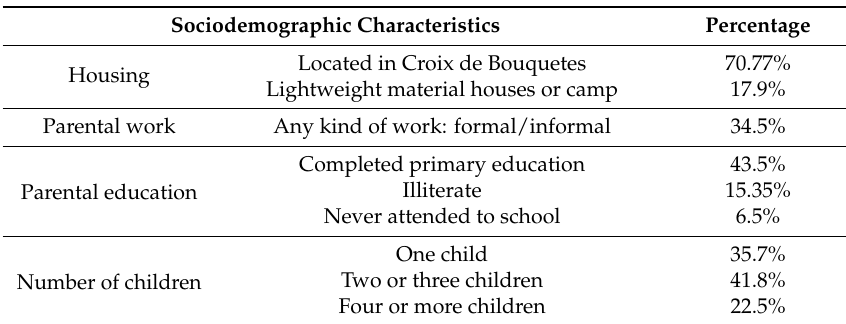
Table 1. General sociodemographic information in in 278 infants that attended the Klinik Saint Espri Health Center, Port au Prince, Haiti (August to September